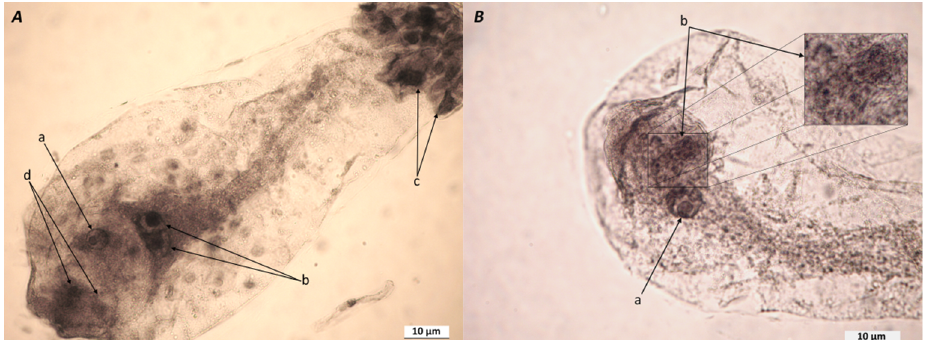
Figure 1. ( A ) Typical embryo sac (ES) isolated from AT-4 ovules at 8 DAAPS. Notes: a, egg cell; b, two polar nuclei of the central cell; c, antipodal complex; d, two synergides. ( B ) Unpollinated ES isolated from AT-4 ovules at 8 DAAPS. Notes: a, central cell nucleus; b, 8-cell parthenogenic proembryo and an enlarged fragment of it. The ESs (A and B) were isolated from acetic-alcohol-fixed ovules, washed, and placed in glycerol–acetocarmine (5:1, v / v ) for 24 h. There also were ESs with additional cells and nuclei in the egg apparatus, synergide- like cells, and ESs with two-celled proembryos or additional egg cells (data not shown). The frequency of spontaneous proembryo formation in the AT-4 line was 10 times higher than the number of parthenogenic proembryos found earlier in the parthenogenic AT-3 line [33].